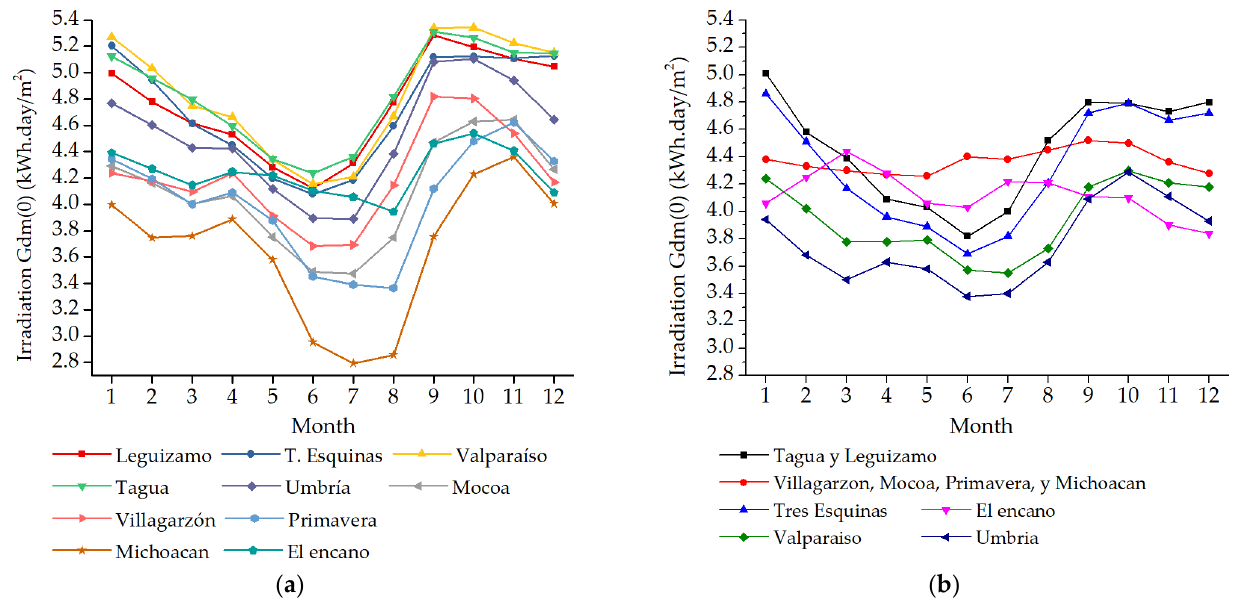
Figure 6. Results of daily monthly averages of solar irradiation from remote sensor databases: ( a ) NREL database; ( b ) NASA database.